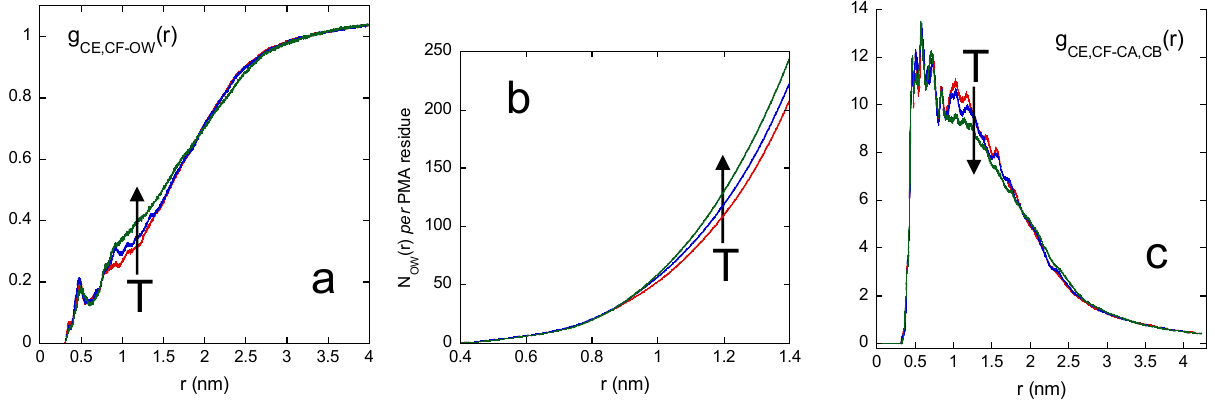
Figure 5. Radial distribution function between: (a) PMA backbone carbon atoms and water oxygen atoms; (b) Average number of water molecules per PMA residue as a function of the distance from the junction chain; (c) radial distribution function between PMA backbone carbon atoms and PVA backbone carbon atoms. Red, blue and green curves refer to 283, 293 and 313 K, respectively. Average over the last ns